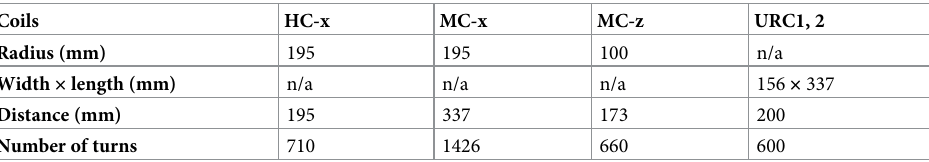
Table 1. Technical specifications of the EMA system.